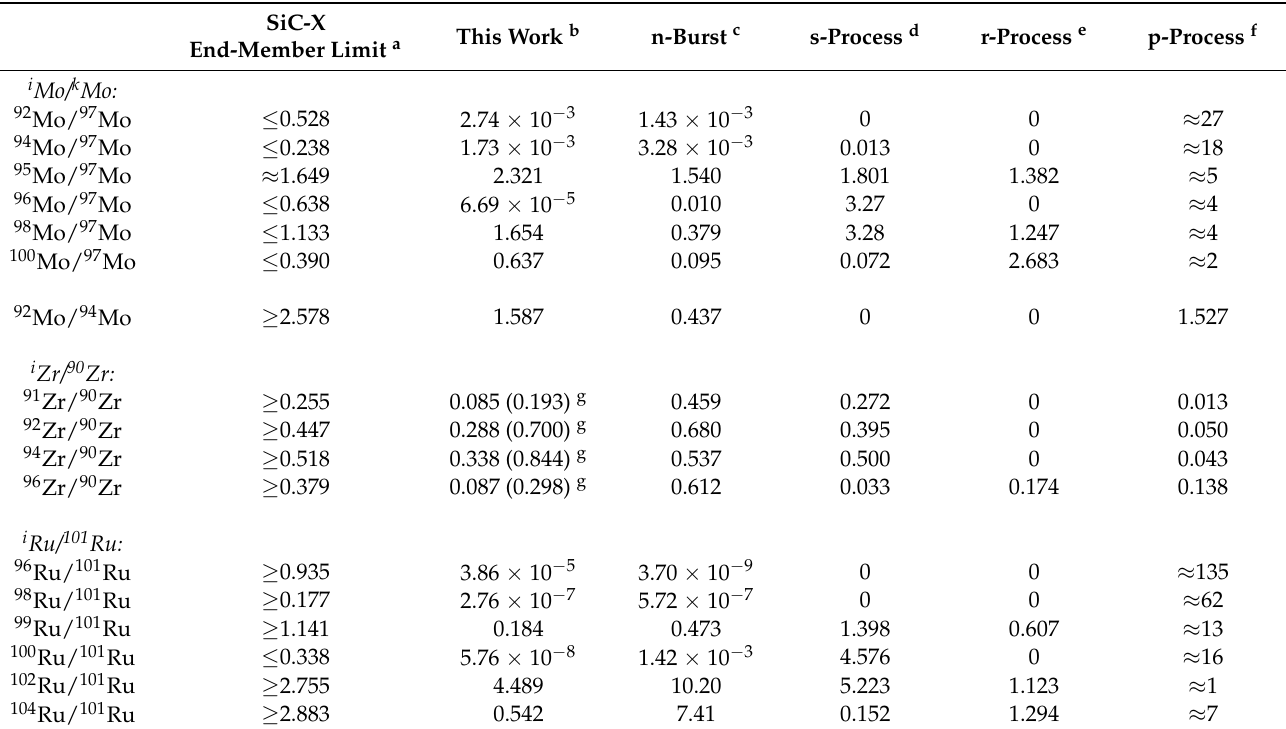
Table 1. Mo, Zr and Ru isotope compositions of the SiC-X end-member and various nucleosynthetic